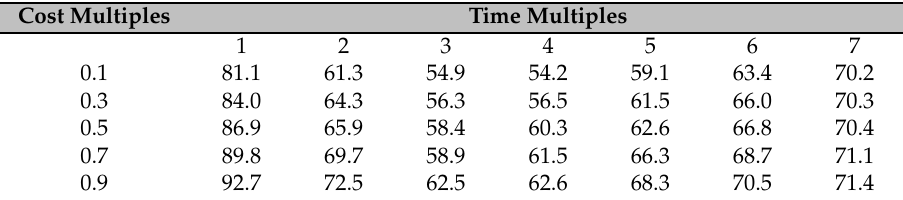
Table 7. Total integrated costs for the small test instance set in $1000s.